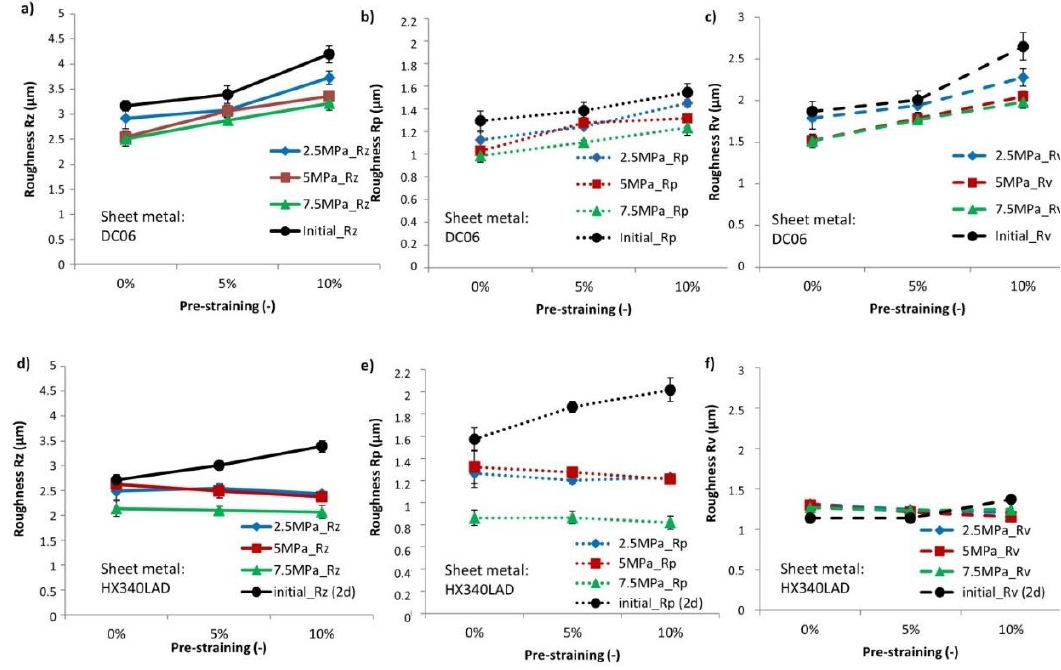
Figure 15. Surface roughness of different pre-straining with variable contact pressure under sliding speed 50 mm/s ( a ) Rz, ( b ) Rp, ( c ) Rv of the surface DC06; Surface roughness ( d ) Rz, ( e ) Rp, ( f ) Rv of the surface